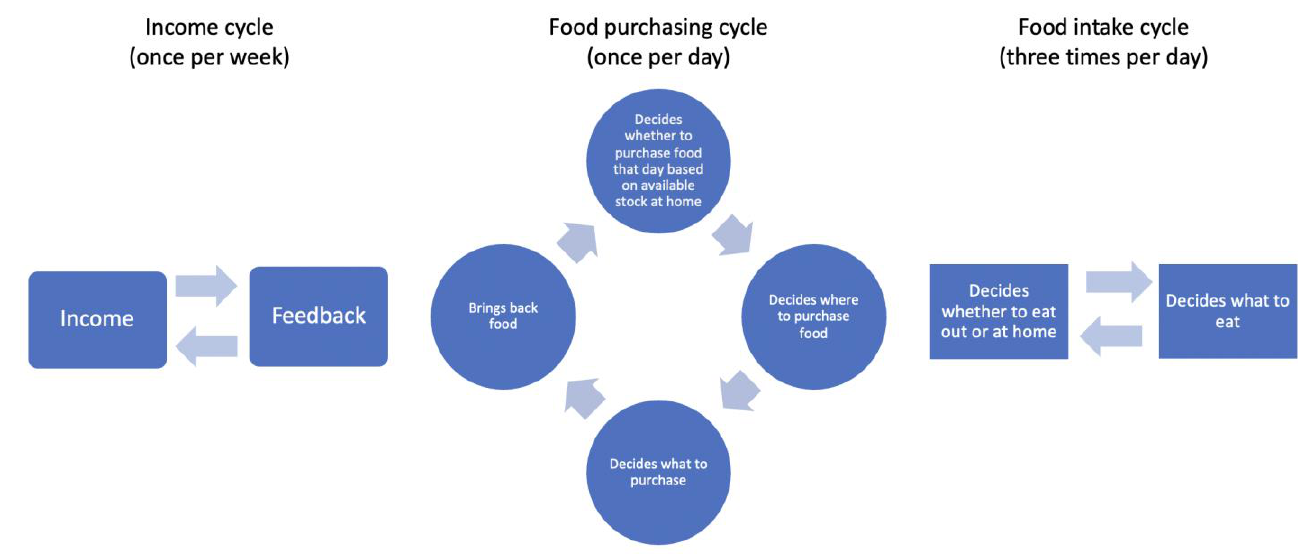
Figure 1. Three cycles of agents’ decision-making process for food purchasing and consumption.